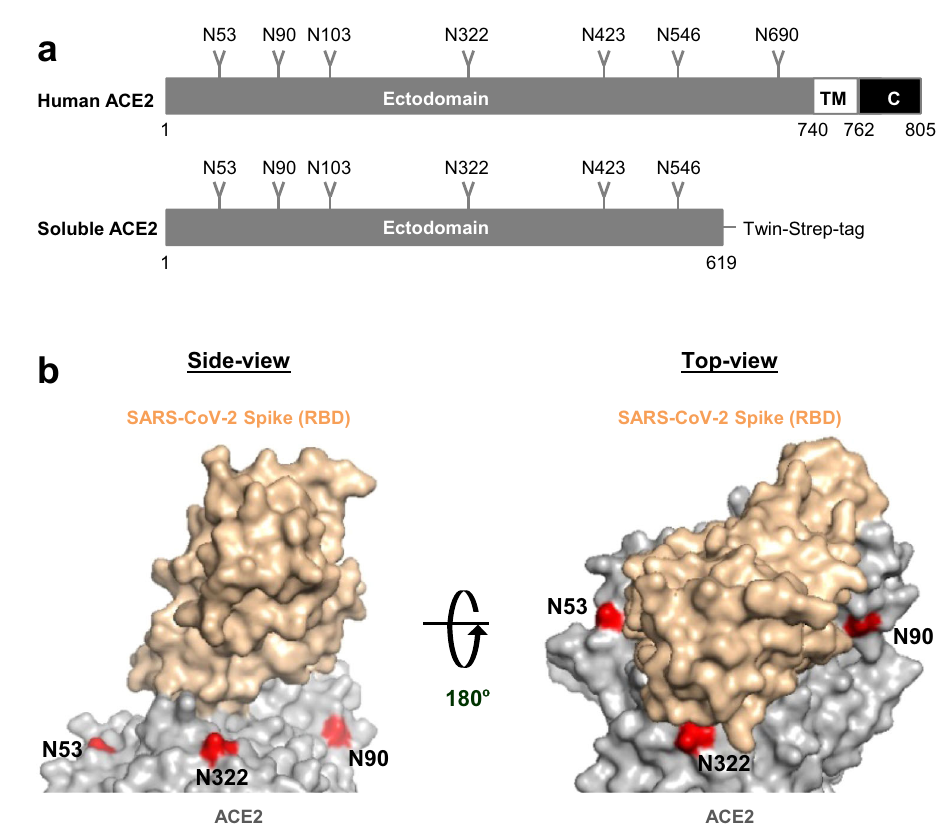
Fig. 1 hACE2 glycosylation deletions. a Schematic of the full-length hACE2 protein domain showing potential N -glycosylation positions on the soluble hACE2 used in this study. b N -glycosylation sites (53, 90, and 322) mapped on to the structure of the hACE2/CoV2 S-RBD (PDB: 6VW1) and colored red. (Left) side-view and (right) top-view. The three glycosylation sites positioned close to the hACE2/CoV2 S-RBD interface were deleted singly or in